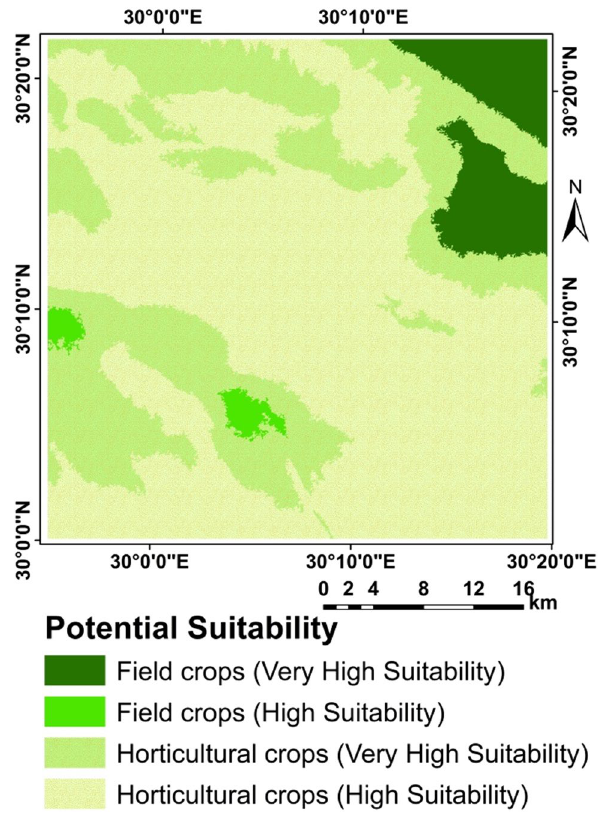
Figure 12. Potential suitability for annual and